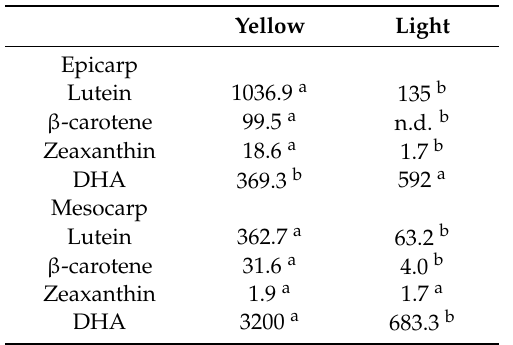
Table 1. Epicarp and mesocarp mean content of lutein, β -carotene, zeaxanthin and dehydroascorbic acid from two zucchini varieties (“Yellow” and “Light green”) expressed in mg/kg dry weight. Yellow